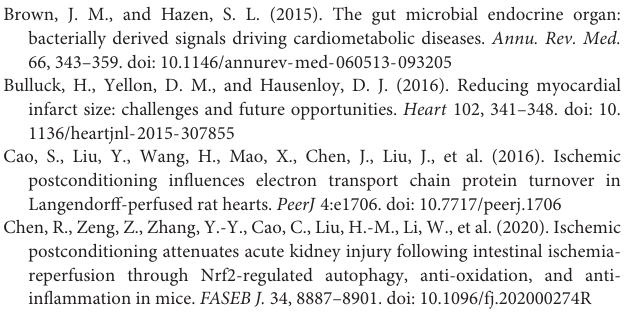
Supplementary Figure 1 | Verify the safety of AAV. (A) Infarct area relative to the area at risk (IA/AAR × 100%). (B) serum CK-MB level. (C) Intestinal water W/D ratios. Serum concentrations of D-LA (D) and I-FABP (E) . (F) Histopathologic changes of the small-intestinal mucosa under light microscopy imaging (H&E staining, Scale bar = 300 µ m). Intestinal mucosa injury was graded by Chiu’s score. (G) Expression of DJ-1 level. S, Sham; IR, ischemia reperfusion; IPo, ischemic postconditioning. Data are mean ± SD or Box-Whisker’s plot ( n = 6); ∗ P <